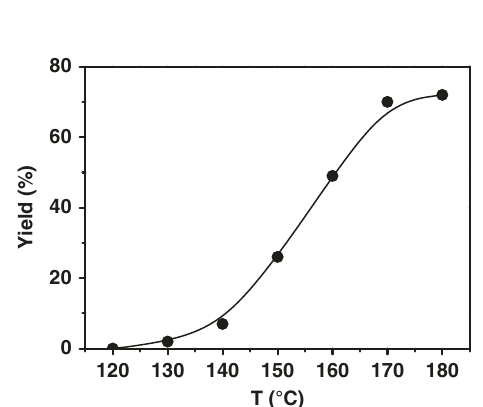
Fig. 2 Impact of reaction temperature. Reaction conditions: 20 μ mol IrI 4 , 2 mmol LiI, 0.6 mL AcOH, 2.45 mmol THF, 5 MPa CO 2 (68 mmol) and 2 MPa H 2 (at room temperature), 16